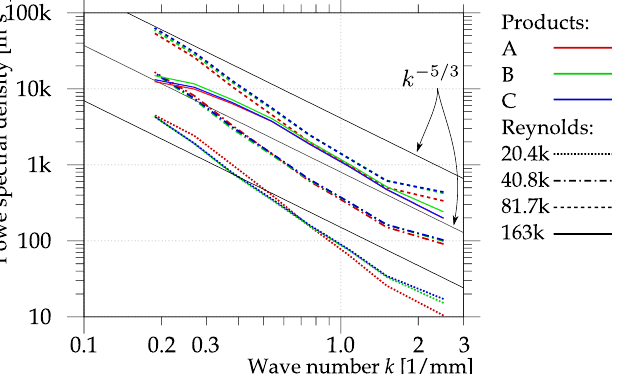
Figure A6. Spatial spectrum of the turbulent kinetic energy at α = 10 ◦ . Products are distinguished with colors, Reynolds numbers wuith different line styles. The thin black lines represent the k − 5/3